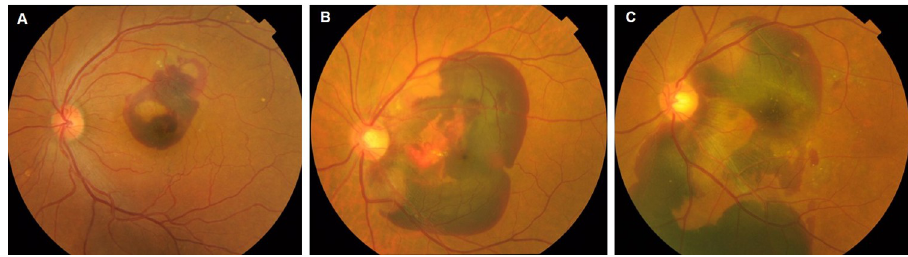
Fig 1. Categorization of SMH size. The image shows the sizes of the SMHs. A: within 5 DA; B: within the arcade vessel, and C: beyond the arcade vessel.